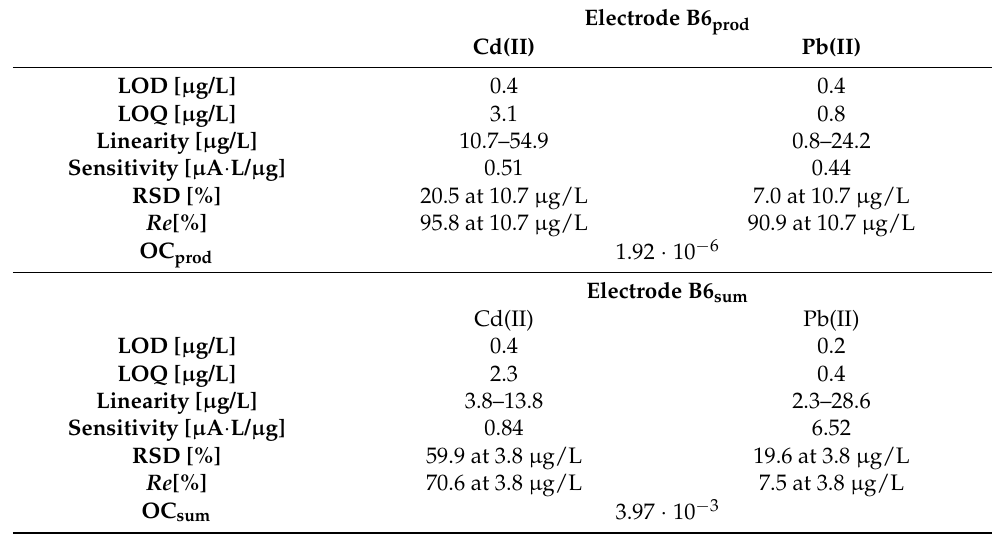
Table 10. A comparison of optimized Electrodes B6 prod and B6 sum